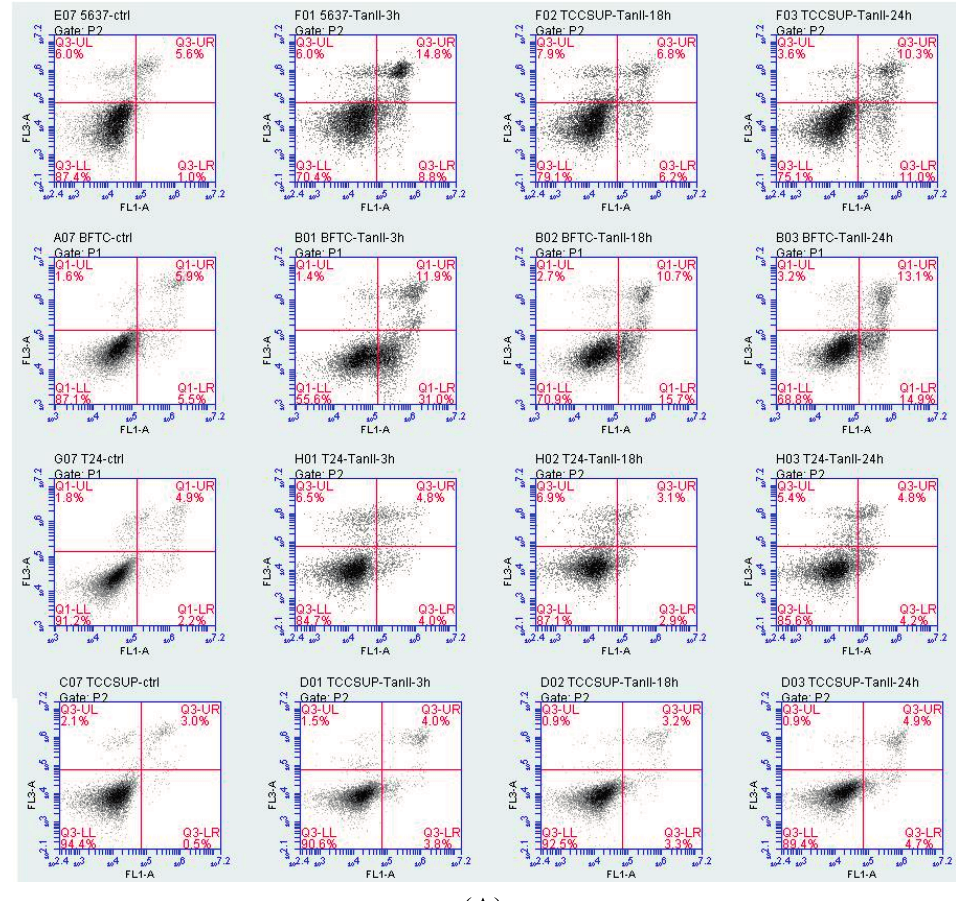
Figure 2. Flow cytometric analysis of bladder cancer cells treated with